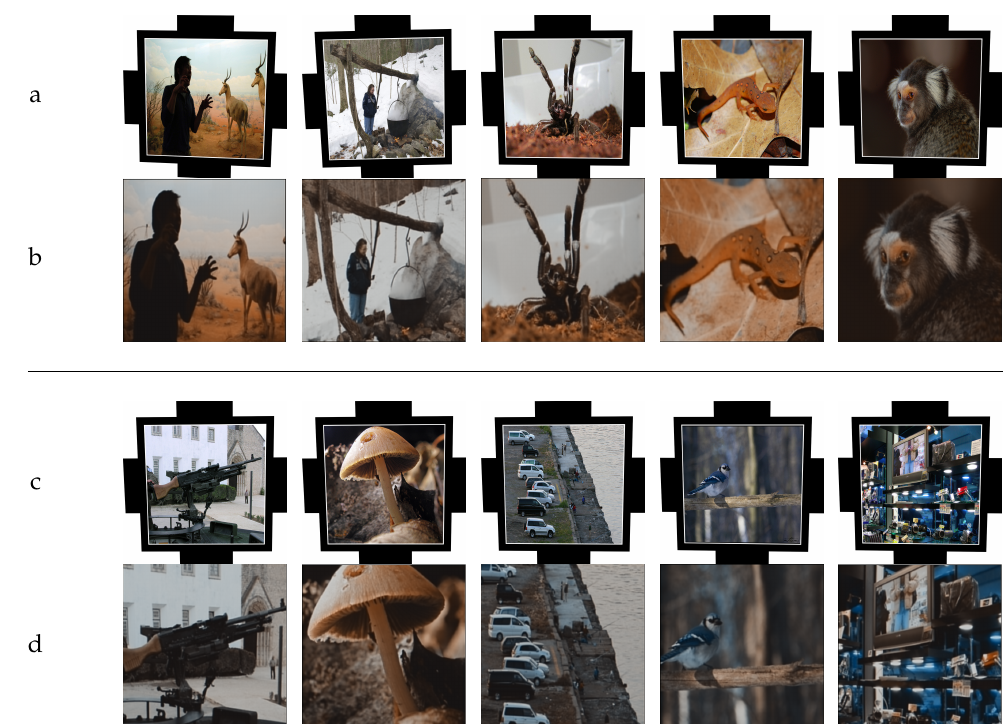
Figure 4. Moiré experiment 1. Examples of image pairs from our test experiment: ( a , c ) pure images; ( b , d ) images (512 × 512) with moiré pattern.